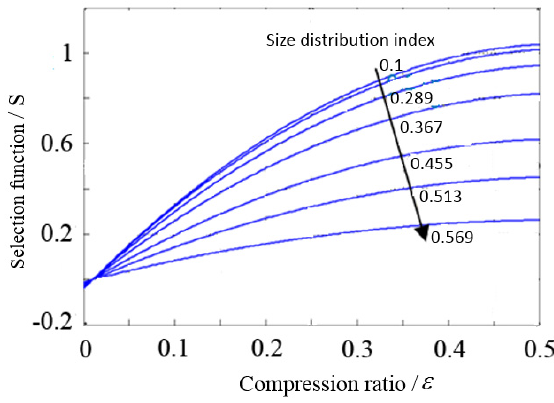
Figure 5. Selection function model.